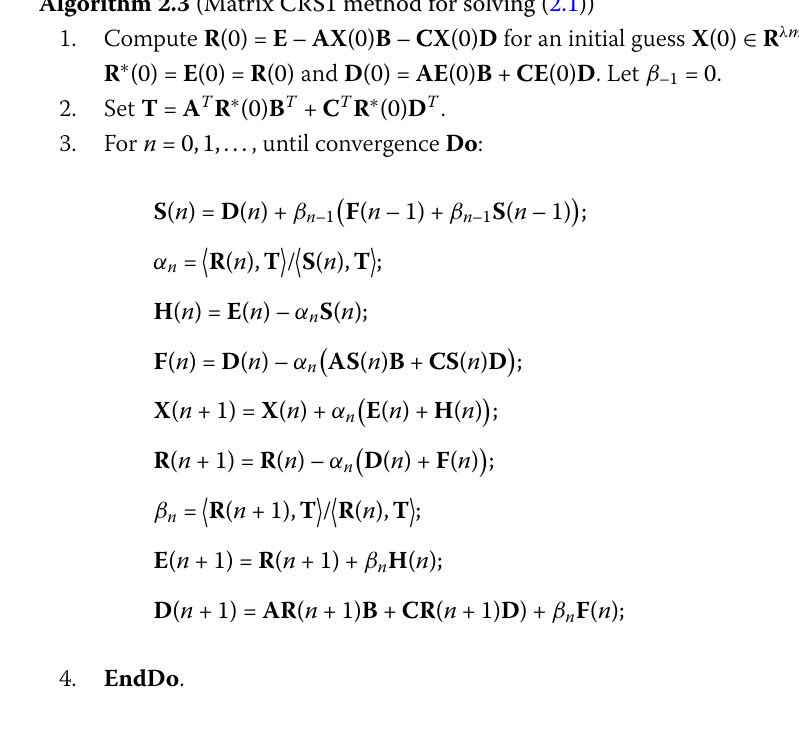
Algorithm 2.4 (Matrix CRS2 method for solving